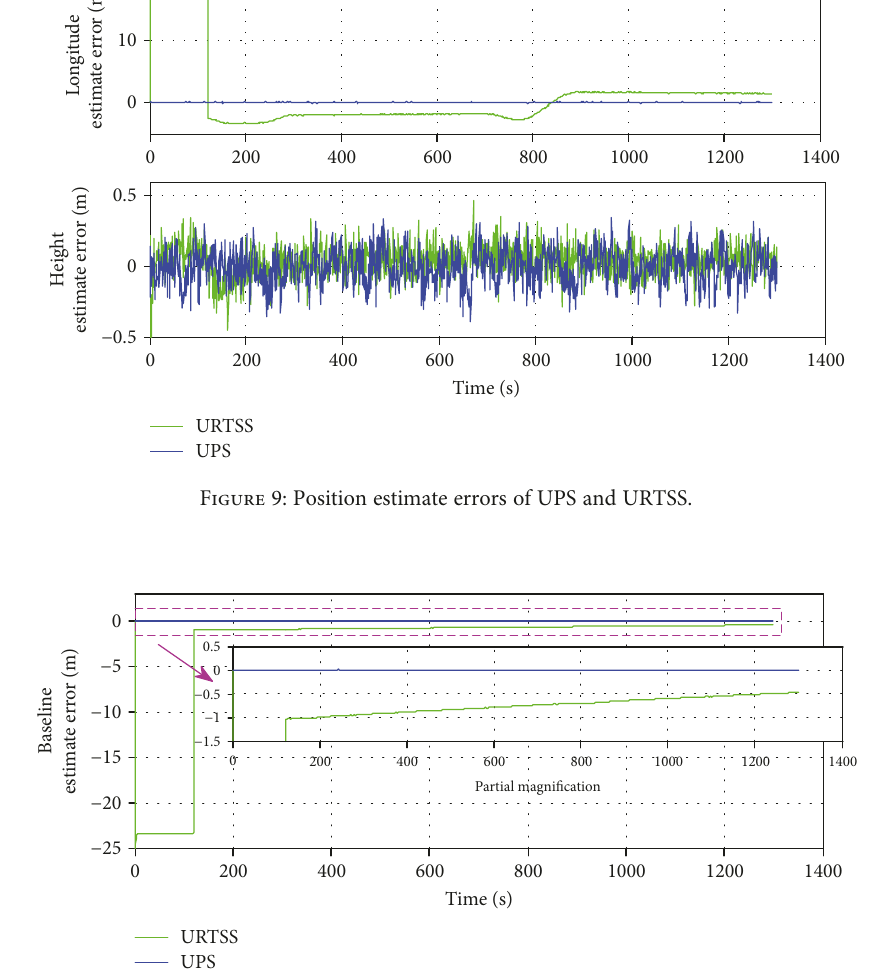
Figure 10: Baseline estimate errors of UPS and URTSS.